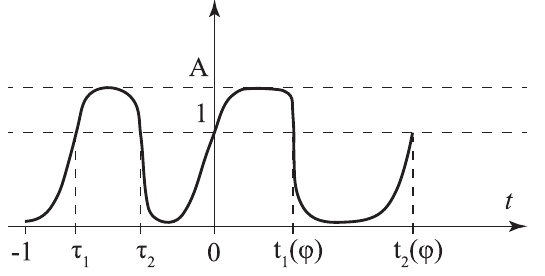
Figure 3. Graph of ϕ ( s ) ∈ S ( τ 1 , τ 2 ) for s ∈ [ − 1,0 ] and u ( t , ϕ ) for t ≥